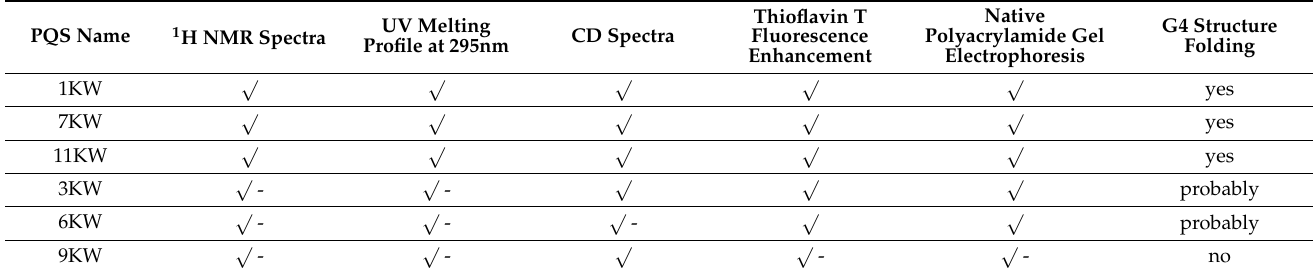
Table 4. Summary of obtained results with different methods for selected PQS